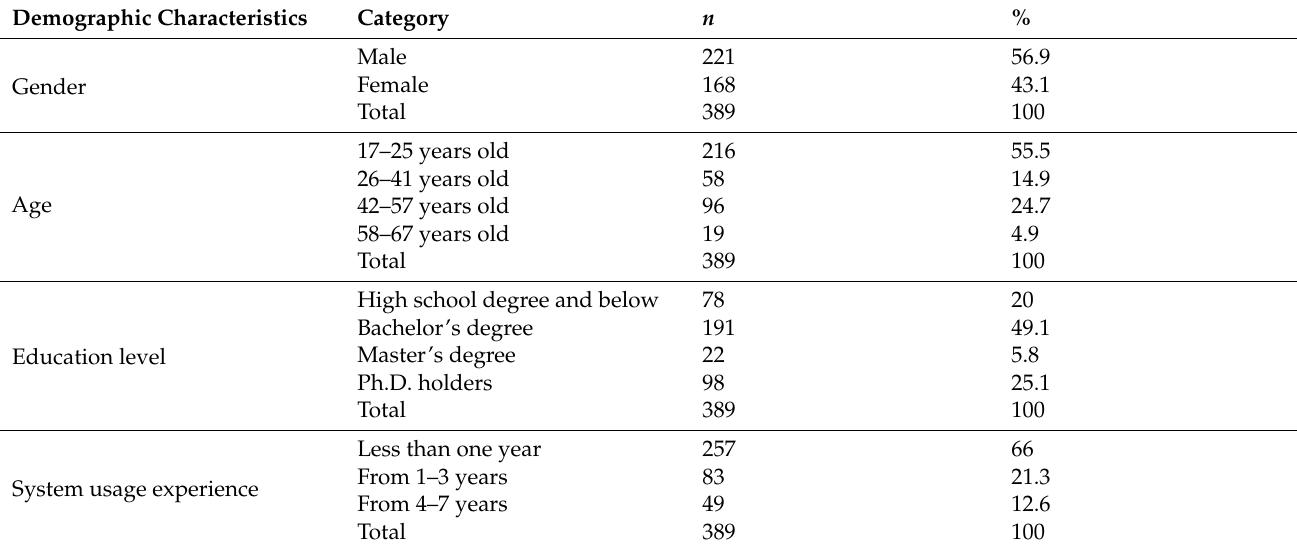
Table 1. Demographic characteristics of the respondents.